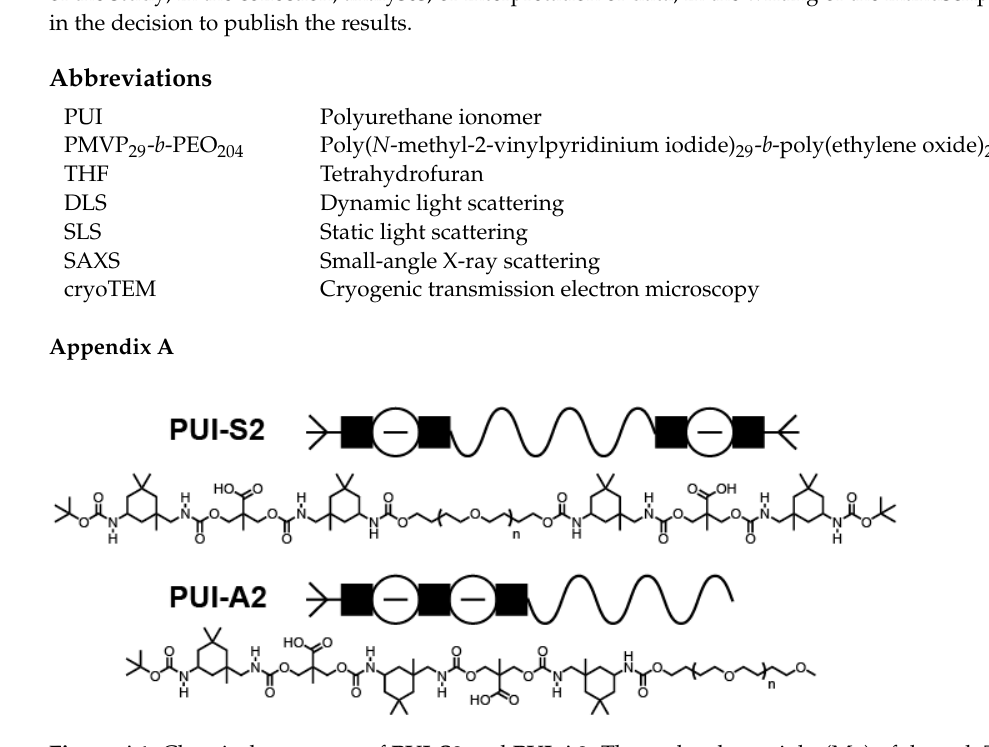
Figure A1. Chemical structures of PUI-S2 and PUI-A2 . The molecular weight (M n ) of the polyTHF block in both PUIs is about 2 kDa.